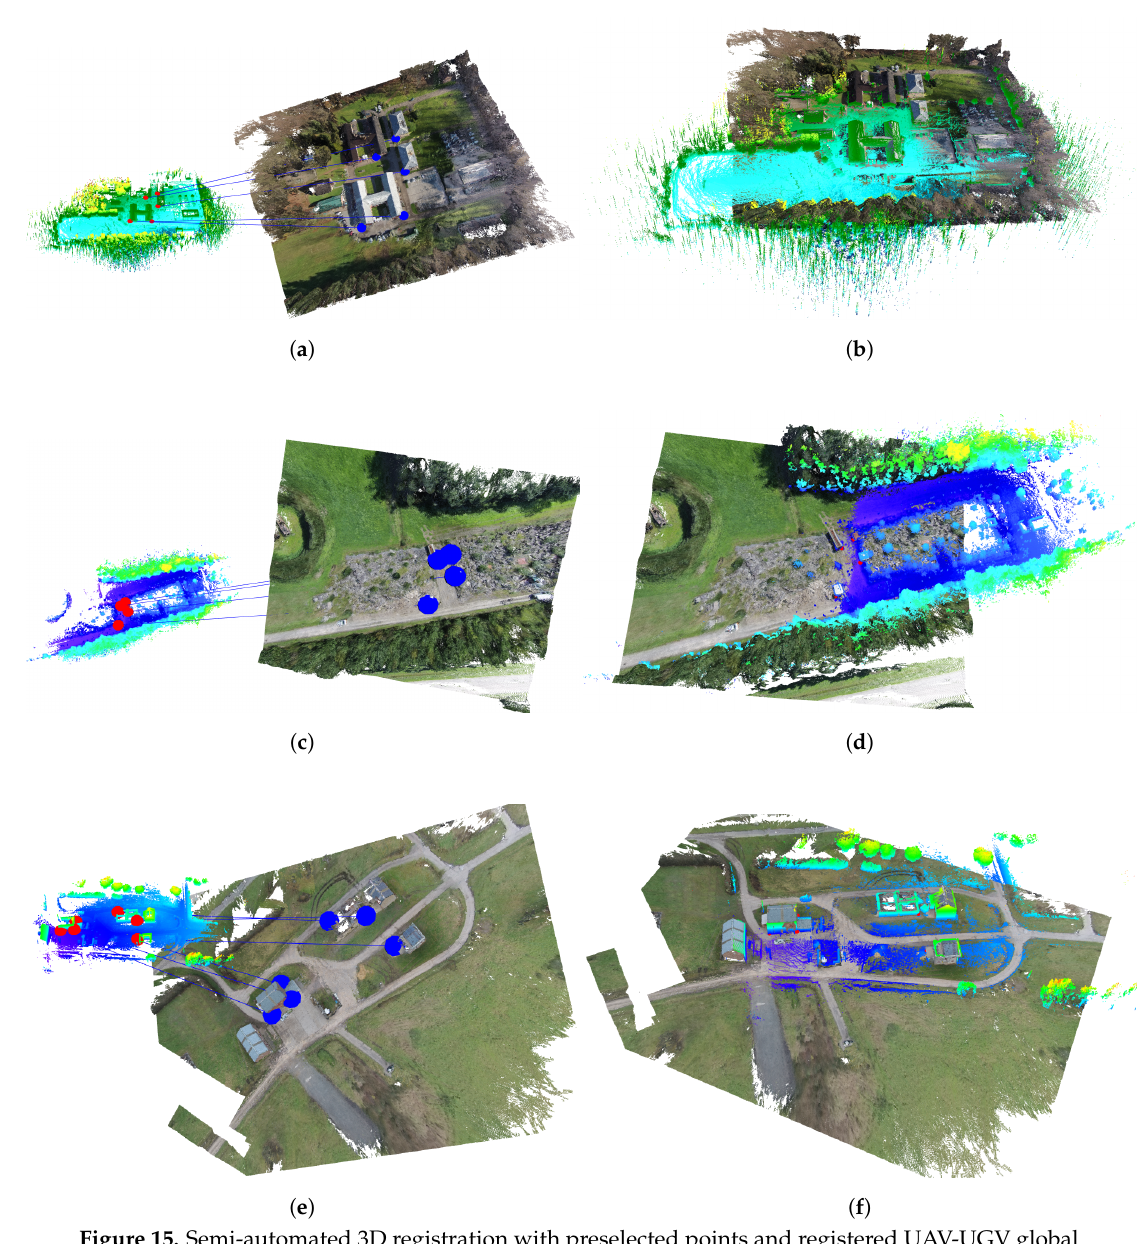
Figure 15. Semi-automated 3D registration with preselected points and registered UAV-UGV global maps, where ( a , c , e ) show the manually selected points, the red points represent the UGV dataset, where the blue points represents the UAV dataset, while ( b , d , f ) show the final output where the semi-automated 3D registration system is applied and the two datasets are registred. Table 4. Homogeneous point cloud